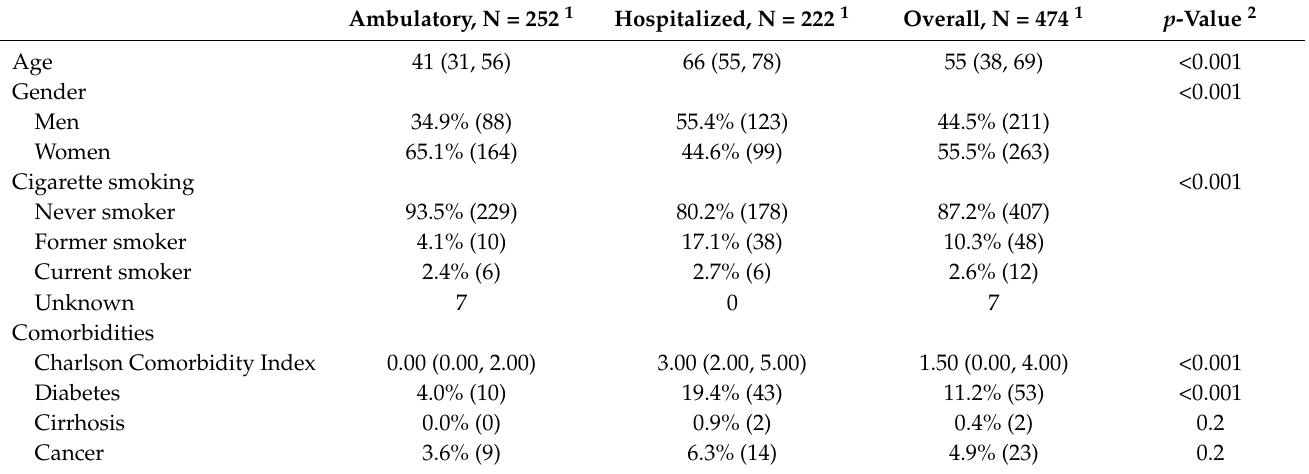
Table 1. Characteristics of the study cohort of responding COVID-19